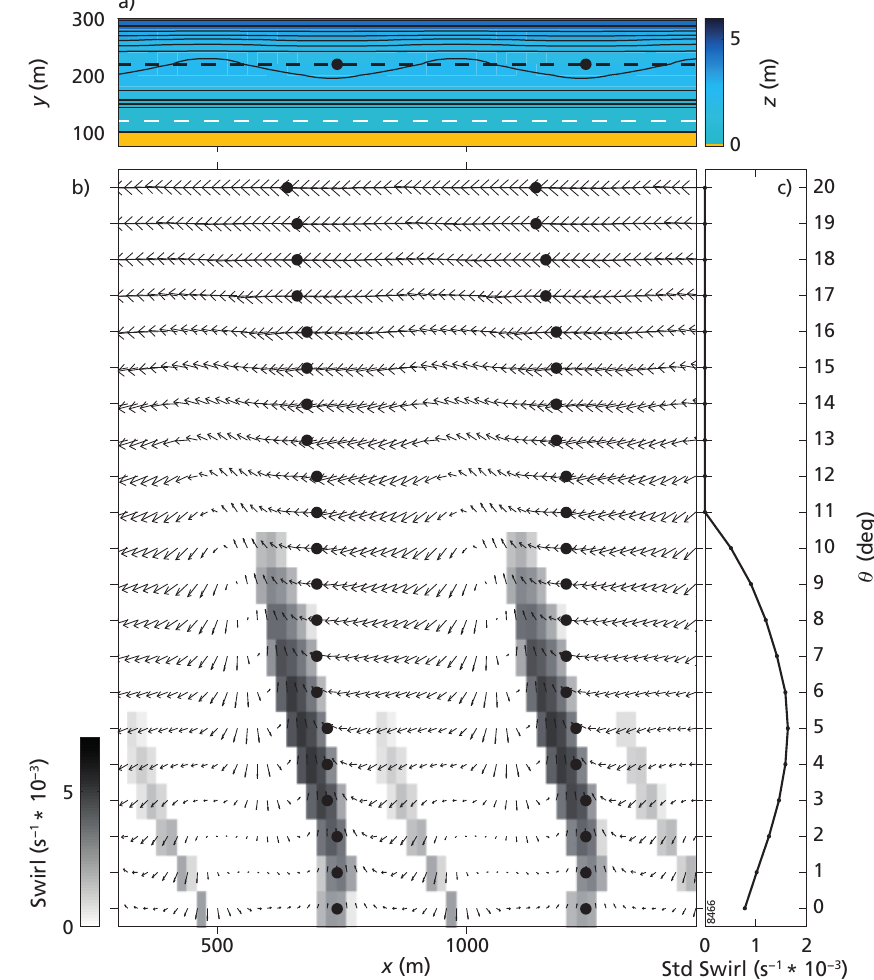
Figure 10. Model results, showing (a) the initial bathymetry, with isobaths (0 . 5m intervals) contoured in the background, (b) flow velocity U (arrows) and swirling strength (shaded) along the inner bar at y = 120m for all simulations after 2 days of simulation, and (c) the corresponding standard deviation of the swirling strength along the inner bar at y = 120 m. The black dots in (a) and (b) indicate the alongshore positions of the outer-bar horns along y = 220m. The swirling strength is a measure of the rotational nature of the flow. Non-zero values imply the presence of cell-circulation patterns. Source: Price et al.